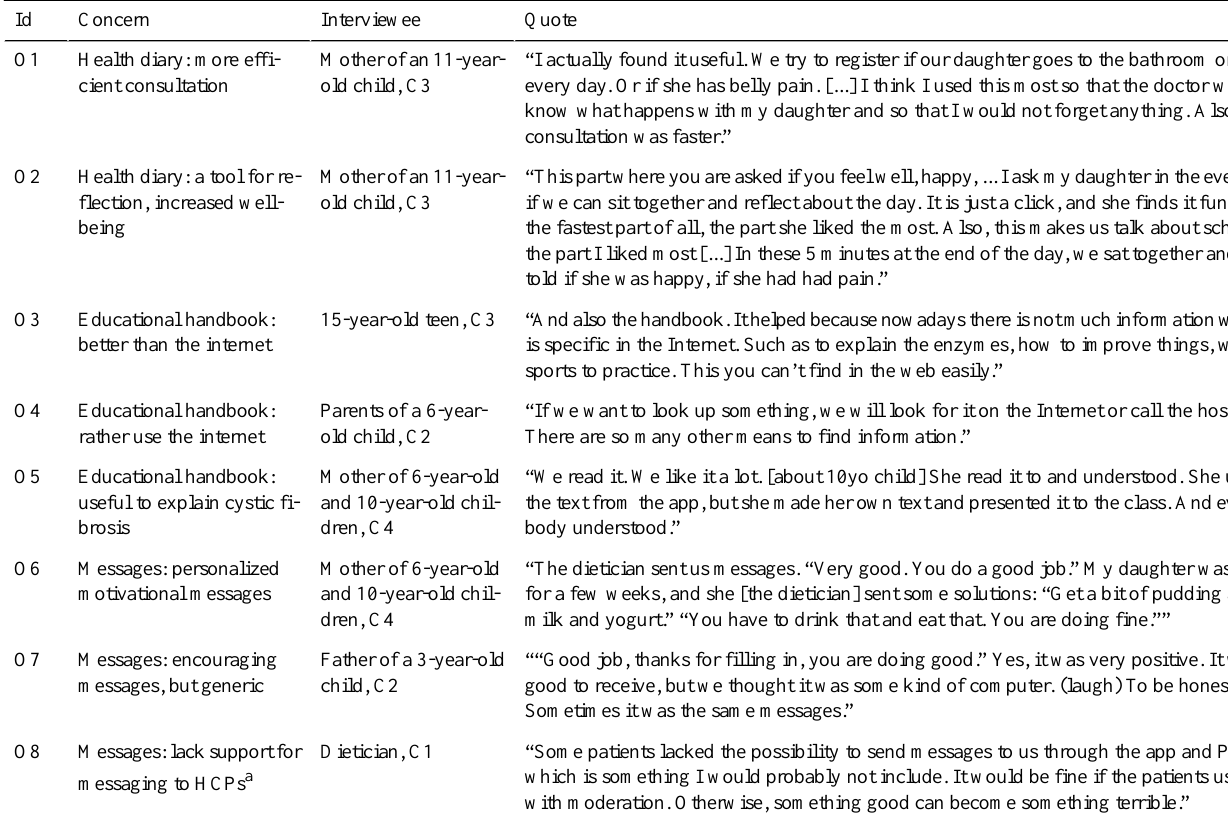
Table 7. Illustrative quotes related to using the self-management app: other features (health diary, educational handbook, and messages from health care